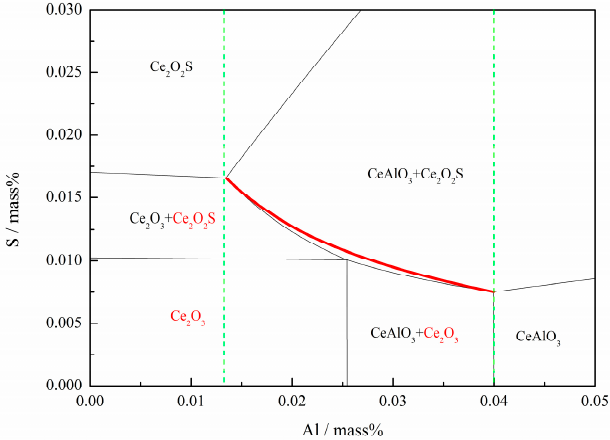
Figure 7. Stability diagram in the Fe-10%Mn-0.001%Mg-0.015%Ce-0.005%O-Al-S system at 1873 K.